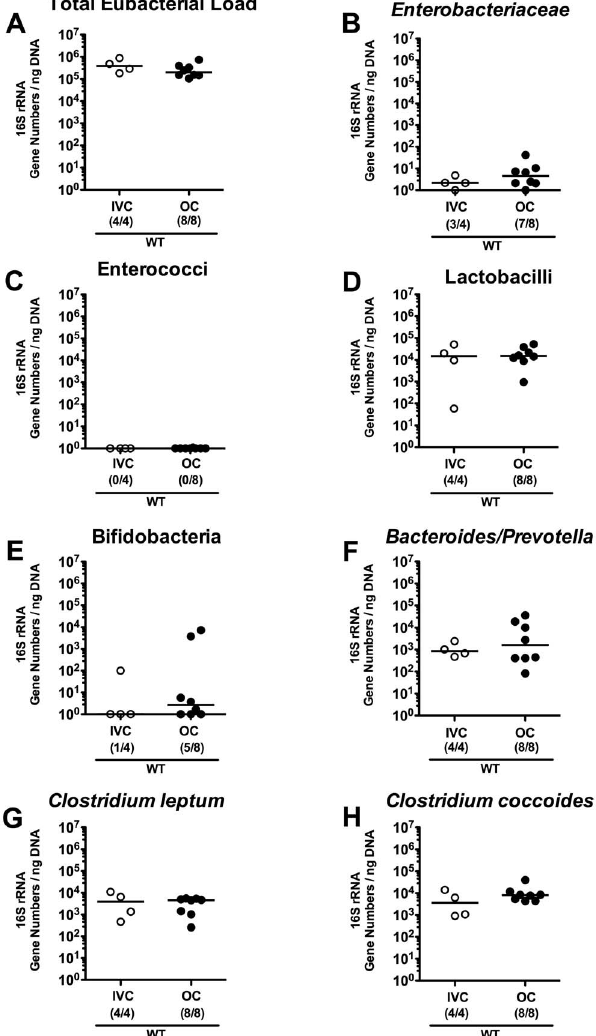
Figure 4. Commensal intestinal microbiota composition of wildtype mice kept in IVC or open cages. After eight weeks of housing in IVC (white circles) or open cages (OC; black circles), 16S rRNA of main intestinal bacterial groups was quantified in fecal samples derived from conventional wildtype (WT) mice. ( A ) Individual total eubacterial loads and quantitative abundance of ( B ) Enterobacteriaceae , ( C ) enterococci, ( D ) lactobacilli, ( E ) bifidobacteria, ( F ) Bacteroides/ Prevotella spp., ( G ) Clostridium leptum group, and ( H ) Clostridium coccoides group are expressed in gene copy-numbers per ng DNA. Medians (black bars) and numbers of mice harboring the respective bacteria out of the total number of analyzed animals (in parentheses) are indicated.